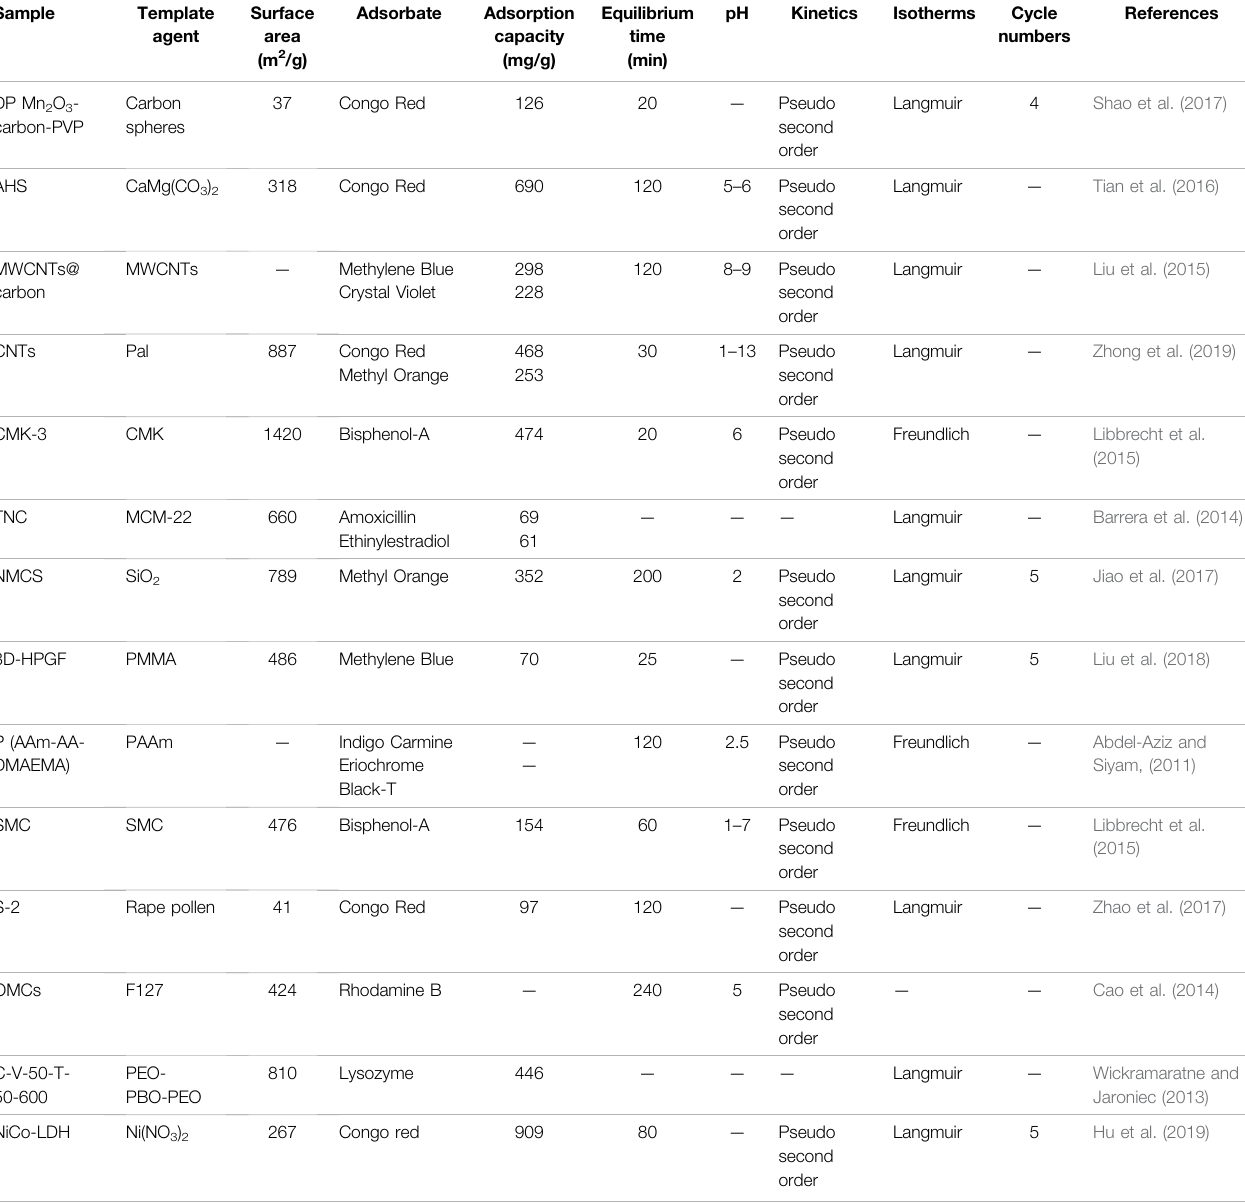
TABLE 4 | Properties of various template materials and their ability to adsorb organic pollutant.